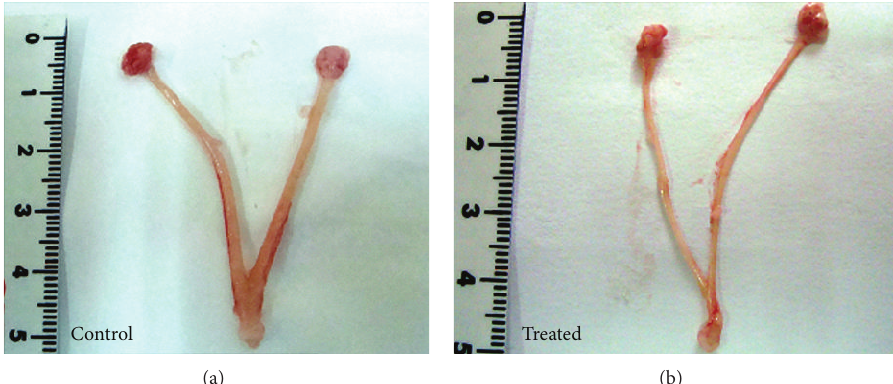
Figure 1: Representative samples from animals being at the proestrous stage of the estral cycle. Morphological observations in reproductive organs from rats receiving an alcohol containing liquid diet during 28 days.